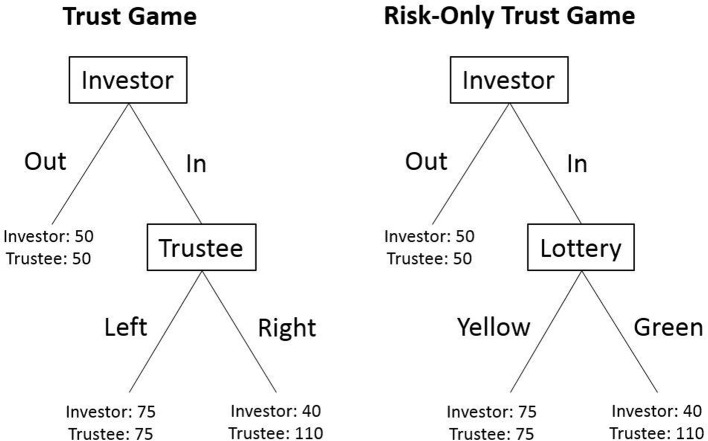
Structural overview of the Betrayal Aversion Elicitation Task, adapted from Aimone et al. (2015) and Quercia (2016).